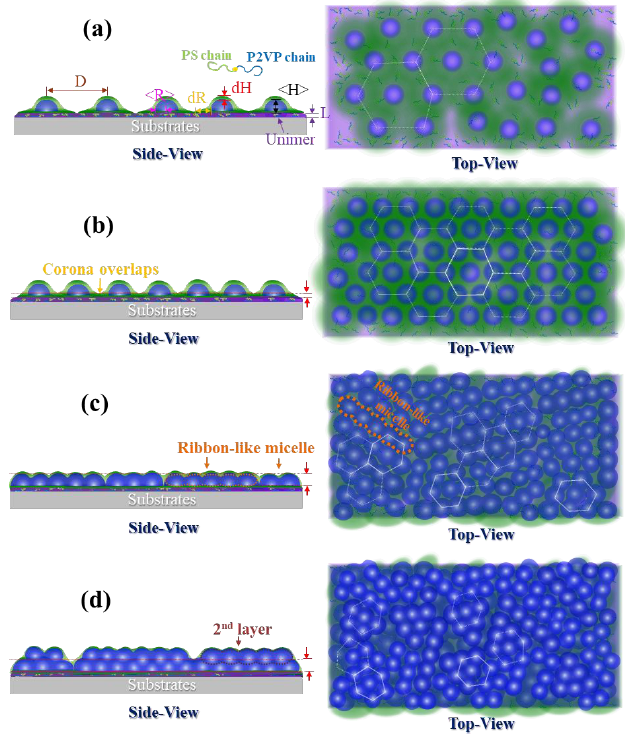
Figure 3. Schematic views of the four stages of P(S- b -2VP) micellar films: ( a ) loosely-packed spherical micelles with short-range order; ( b ) loosely packed spherical micelles with long-range hexagonal order; ( c ) ribbon-like nanostructures formed through anisotropic merging of spherical micelles; and ( d ) a second layer of spherical micelles with short-range order depositing at valleys between ribbon-like nanostructures. The radius, height of P2VP cores, the thickness of PS shells, the thickness of a homogenous layer, and the nearest-neighbor distance of spherical micelles are denoted by the labels < R >, < H >, dR, dH , L , and D, respectively.